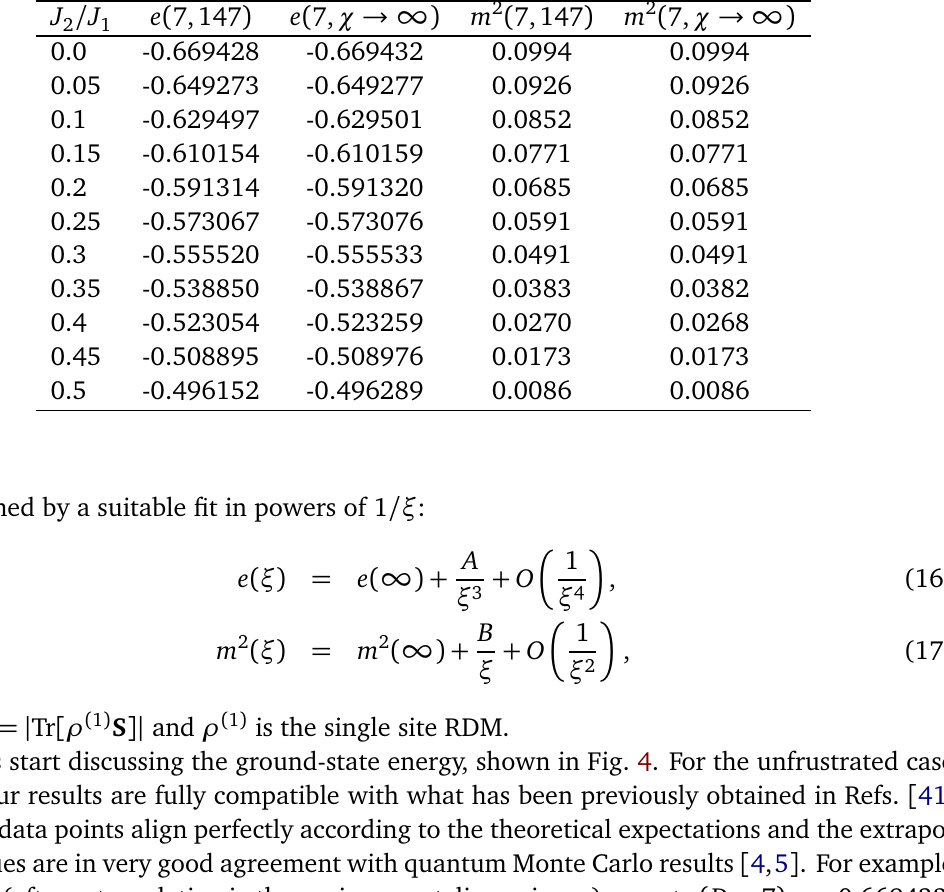
Table 2: Ground-state energies (in units of J m 2 ( D , χ ) for D = 7, which can be considered as upper bounds of the exact D → ∞ values. The tensor was optimized up to an environment dimension χ = 3 D 2 = 147. The χ → ∞ extrapolations are done from environment bond opt dimensions χ ∈ [ D 2 ,13 D 2 ]